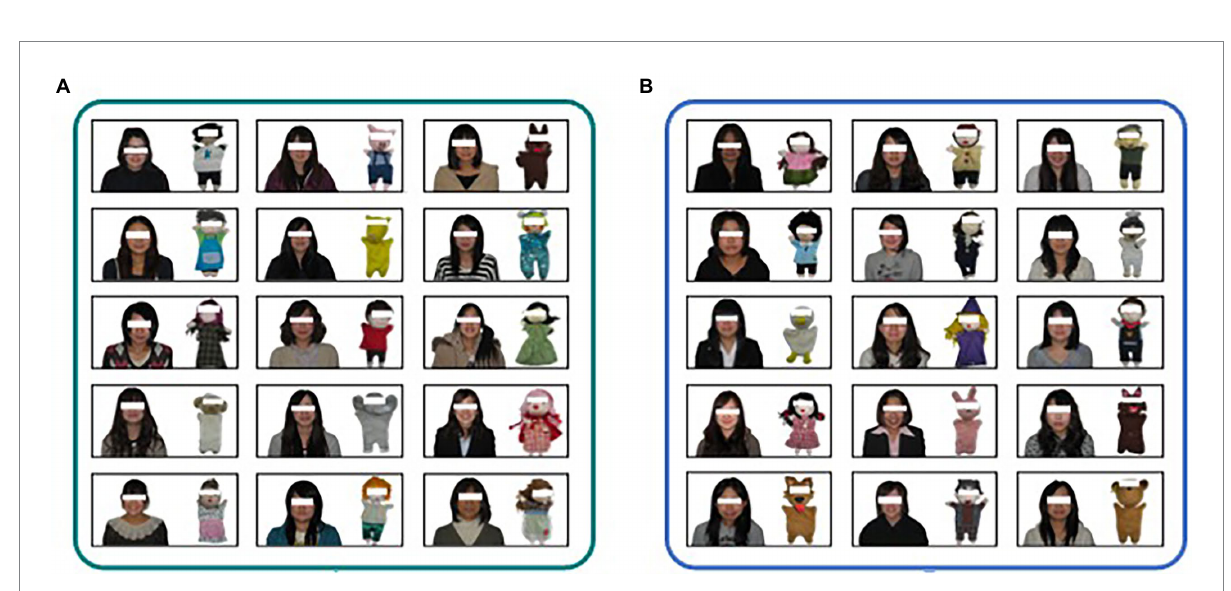
FIGURE 2 A sample of stimuli in Experiment 1. The participants were required to choose the matching doll-maker pairs, (A) or (B)